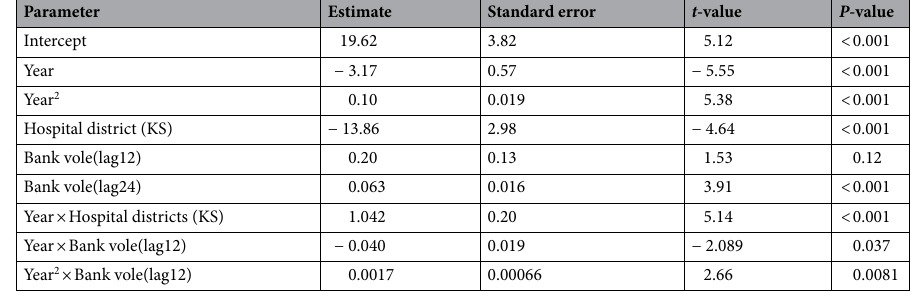
Table 1. Output of linear mixed effect models (fixed effects) fitted with the maximum likelihood method explaining incidence of laboratory-diagnosed Lyme Borreliosis (LBlab) in the Central Finland (KS) and Northern Savo (PS) hospital districts from 1995 to 2019 in relation to year and bank vole abundance. Month was used as a random effect. Temporal autocorrelation of residuals was modelled with the AR(2) function. Model adjusted R 2 =